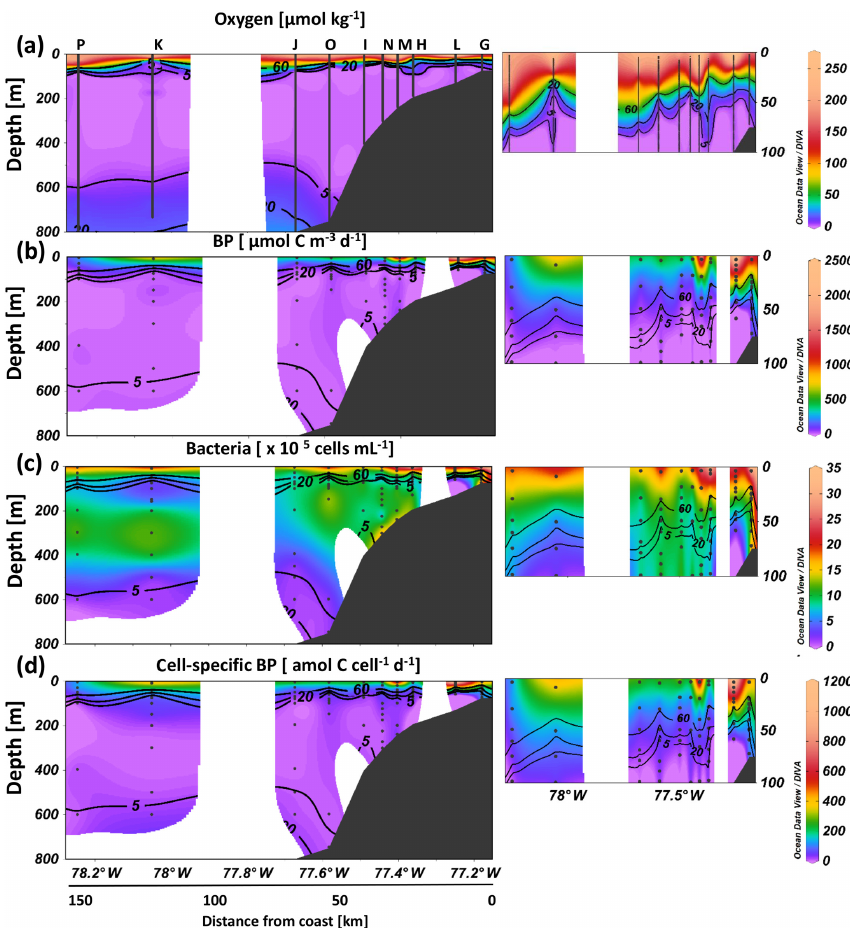
Figure 4. Bacterial growth activity at different in situ oxygen concentrations from on- to offshore off Peru during April 2017 (M136). Oxygen concentrations (a) , total bacterial production (BP) (b) , bacterial abundance (c) and cell-specific BP (d) over the upper 800m depth with a zoom in the upper 100m (small